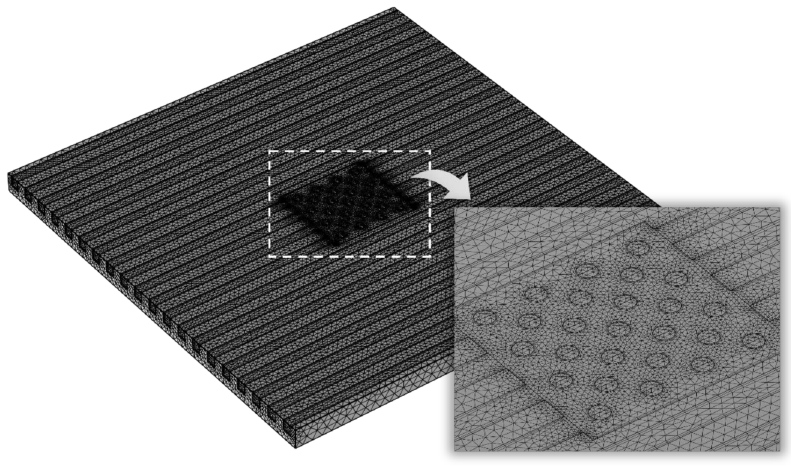
Figure 5. Schematic diagram of meshes generated in the microchannel pin-fin hybrid heat